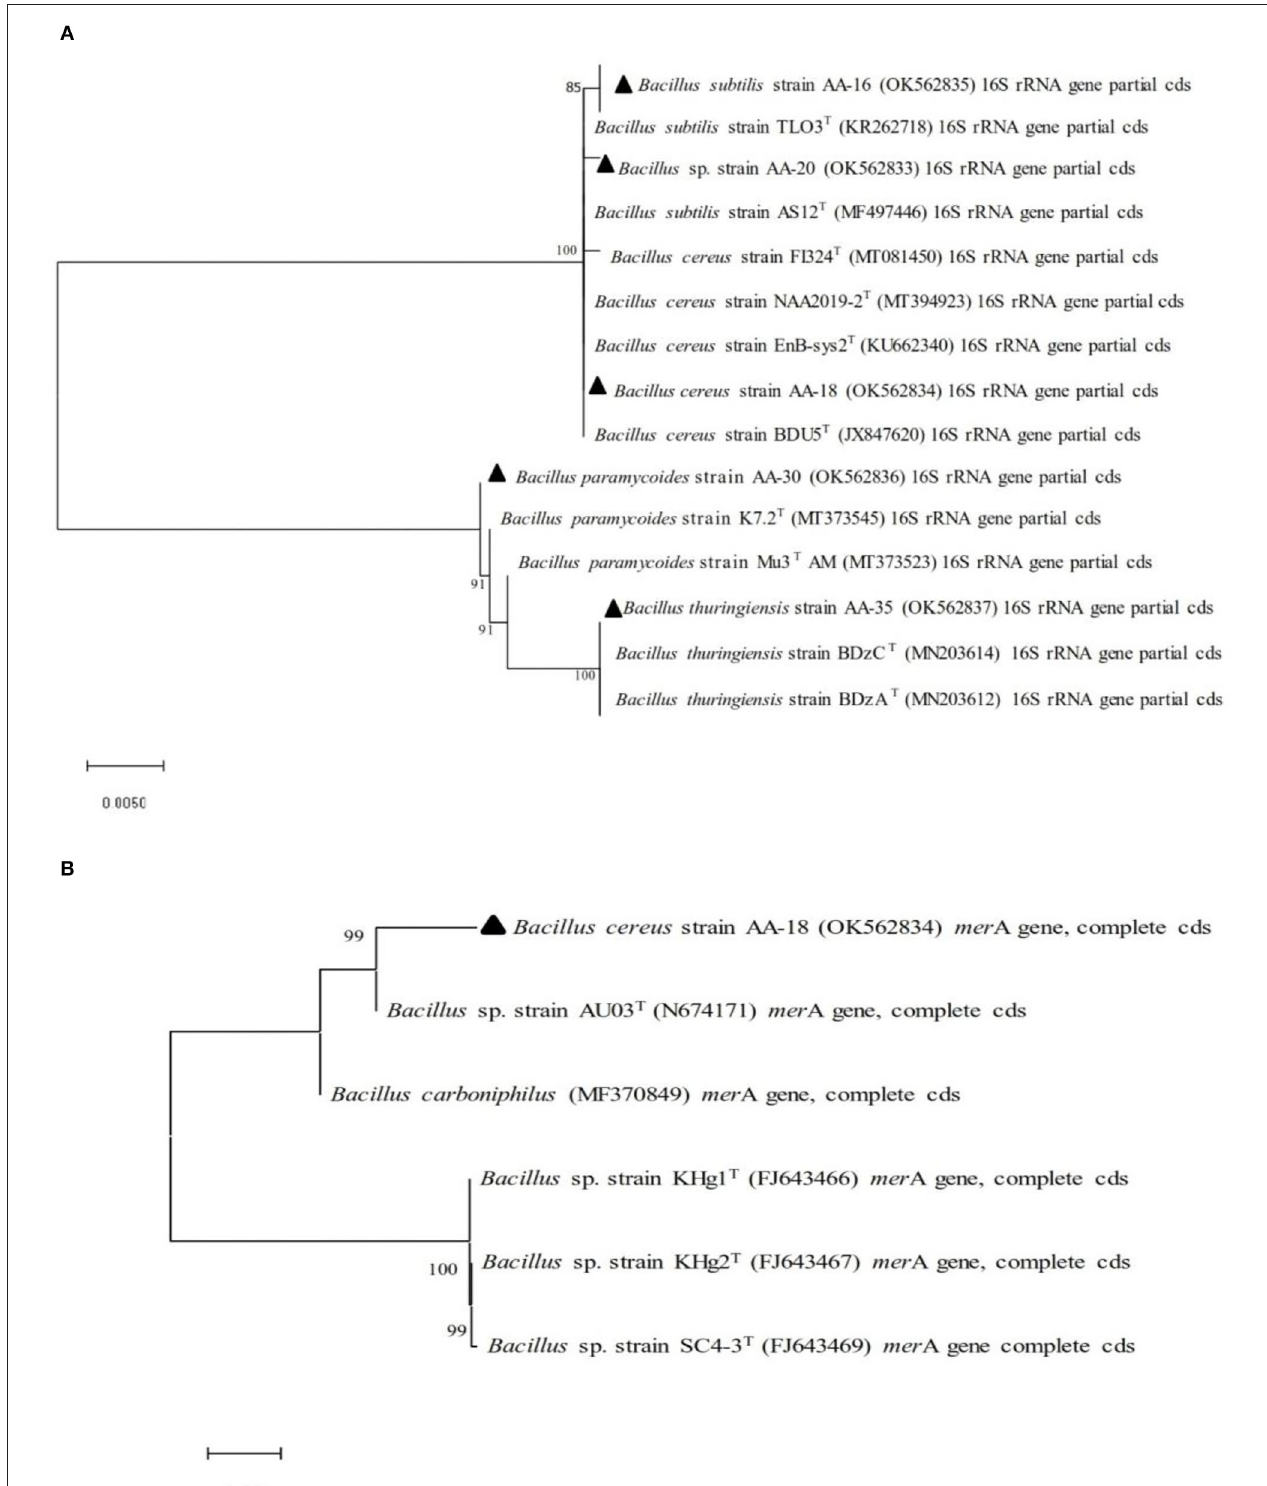
FIGURE 1 | Phylogenetic analysis performed by neighbor-joining method of selected Hg-resistant bacterial strains with other closely related species based on (A) 16S rRNA gene sequence and (B) mer A gene sequence.